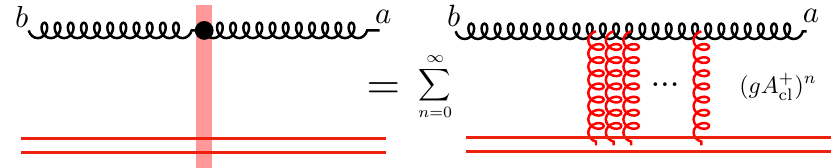
Figure 3 . The effective vertex of the dressed gluon propagator on the l.h.s. of the figure represents multiple scattering off the classical gauge fields A + The n = 0 term represents the free gluon